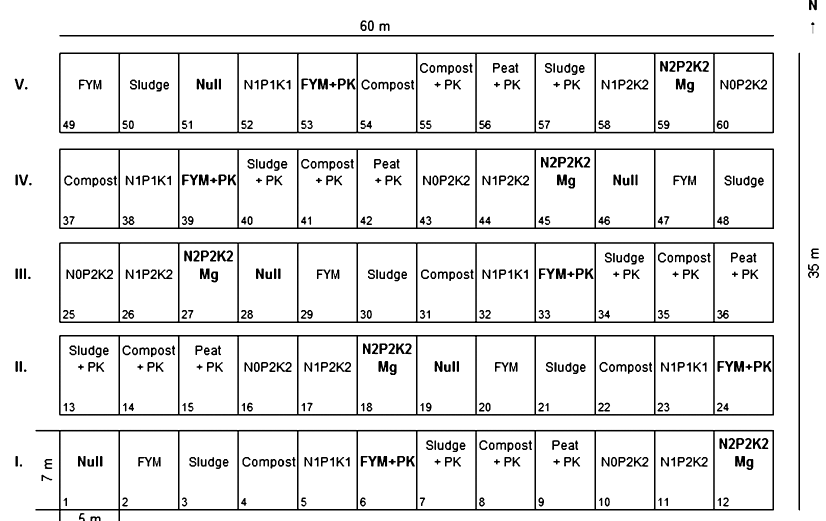
Figure 1. Spatial arrangement of the ZOFE field trial in Zurich indicating 12 treatments with five replicates each arranged in five blocks (I– V). Plot numbers in the lower left corner are listed together with measurements in Table 1. Treatments in bold (Null, FYM + PK, N2P2K2Mg) were used for the present study. For a detailed description of all treatments, please see Oberholzer et al.